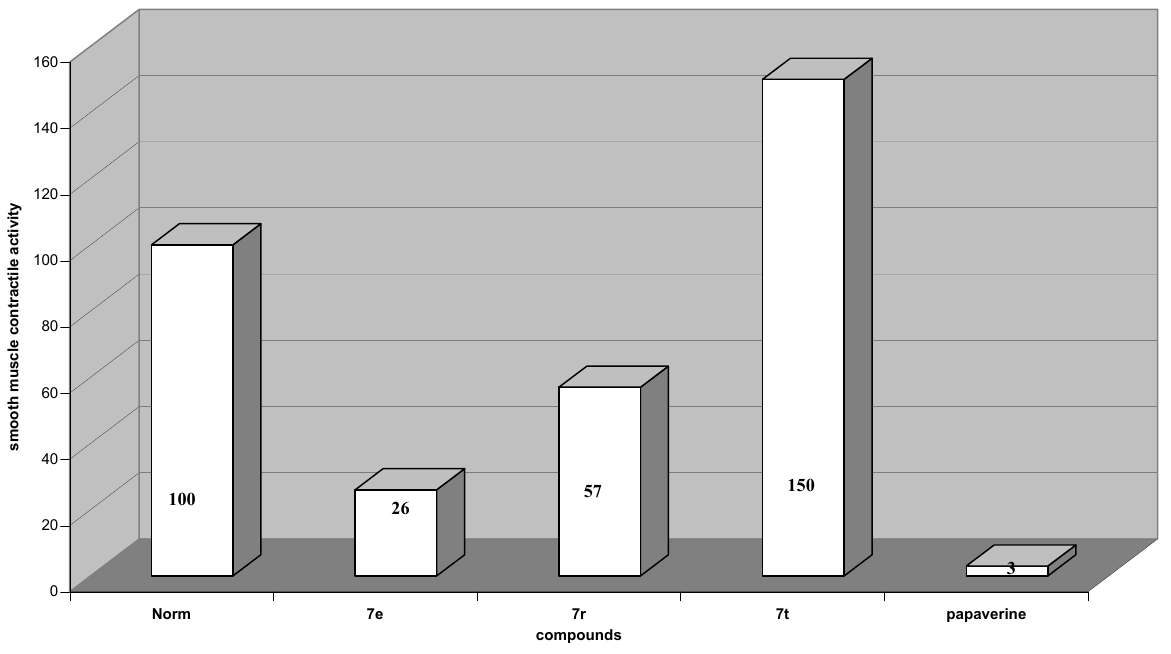
Figure 2. Change of spontaneous contractile activity of gastric smooth muscles preparation after using 1,1-disubstituted 1,2,3,4-tetrahydroisoquinoline derivatives and papaverine, normal activity is taken for